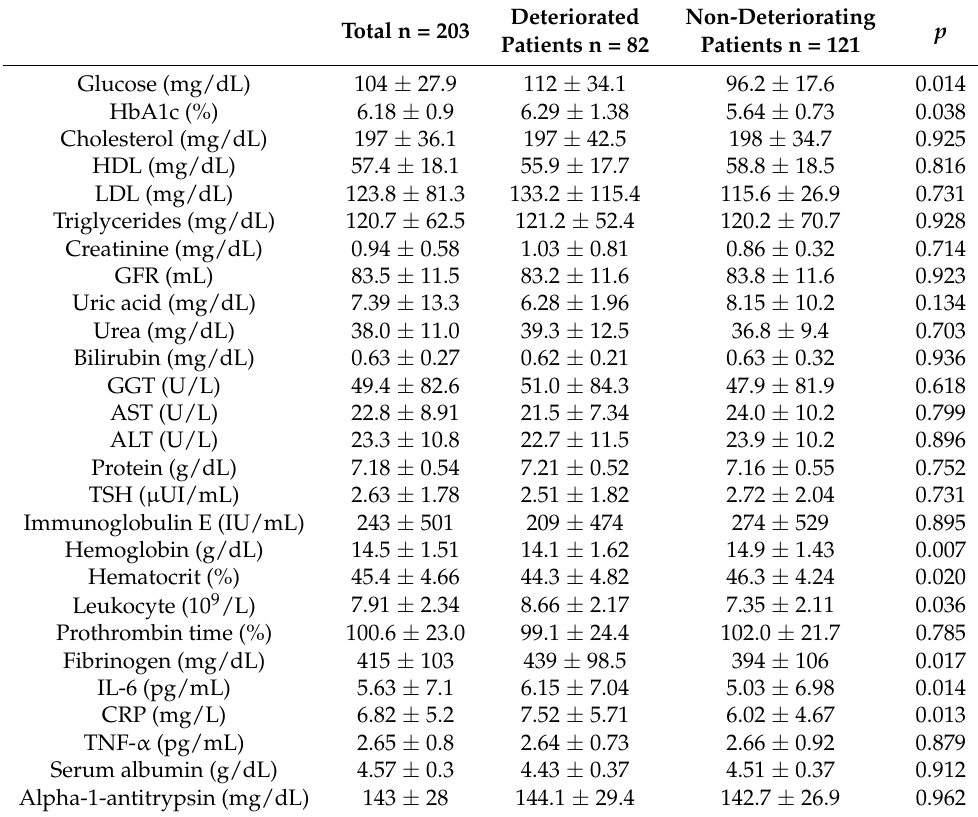
Table 2. Population characteristics and inflammatory markers by phenotype.